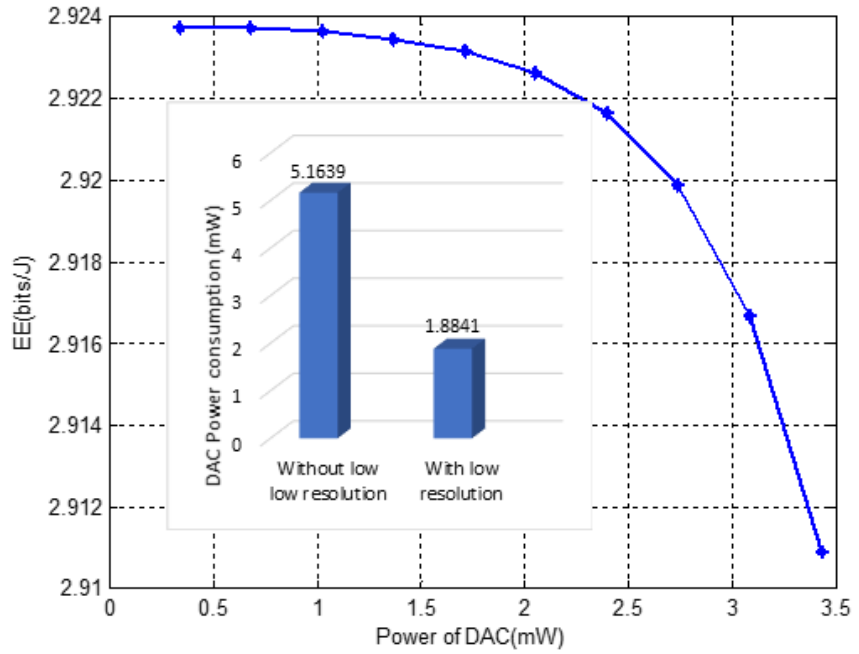
Figure 4. EE evaluation with different DAC power values, and evaluation of the total power con- sumption with and without low DAC resolution at randomly generated bits.